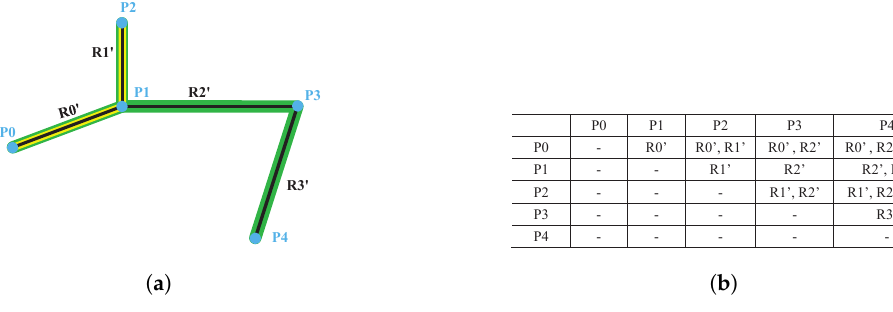
Figure 1. Representation of a road scene and its corresponding connectivity matrix. ( a ) A road scene showing four individual roads (black line segments: R0’, R1’, R2’, and R3’); one composite road (yellow line: R0’ and R1’); and five individual road endpoints (blue circles) and their IDs (black and blue colors correspond to roads and endpoints, respectively). ( b ) Connectivity matrix of the road network shown in Figure 1a.